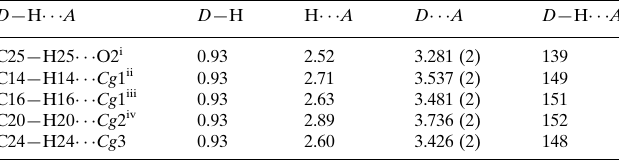
Hydrogen-bond geometry (A˚ , (cid:2)